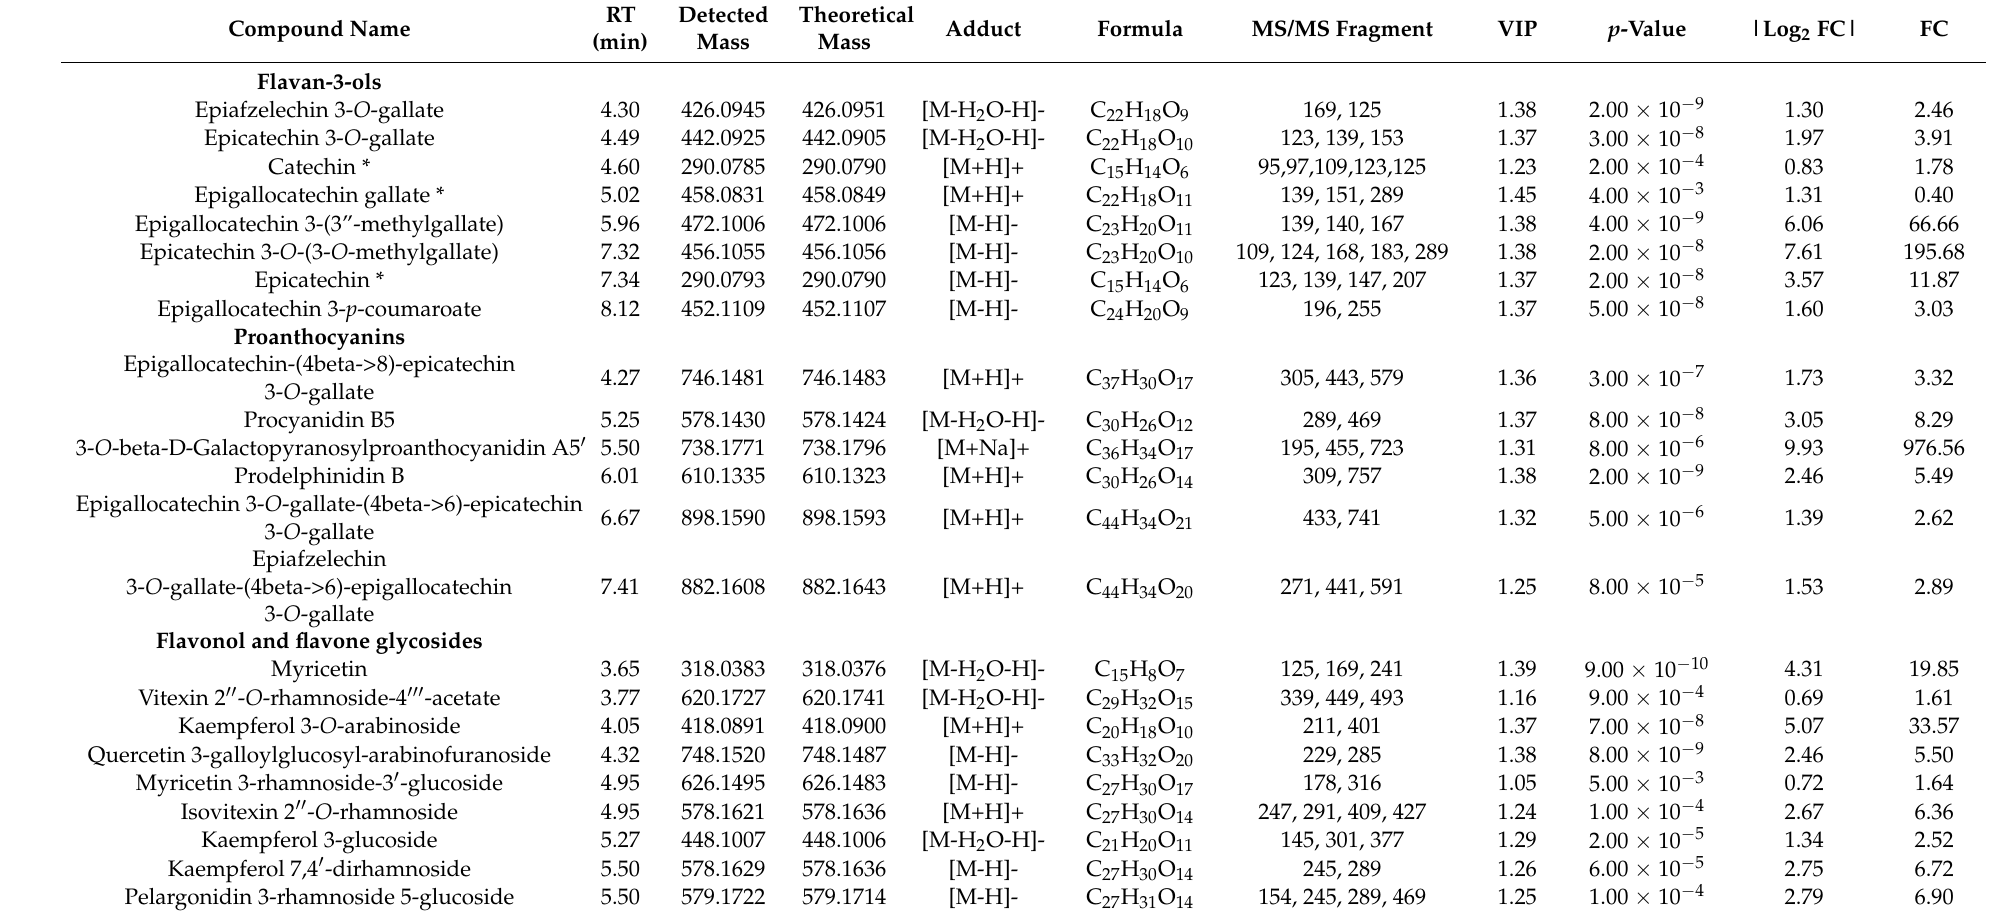
Table 1. Differential metabolites in ZJT and YKT samples by metabolomics analysis based on ultra-high performance liquid chromatography combined with Orbitrap mass spectrometry